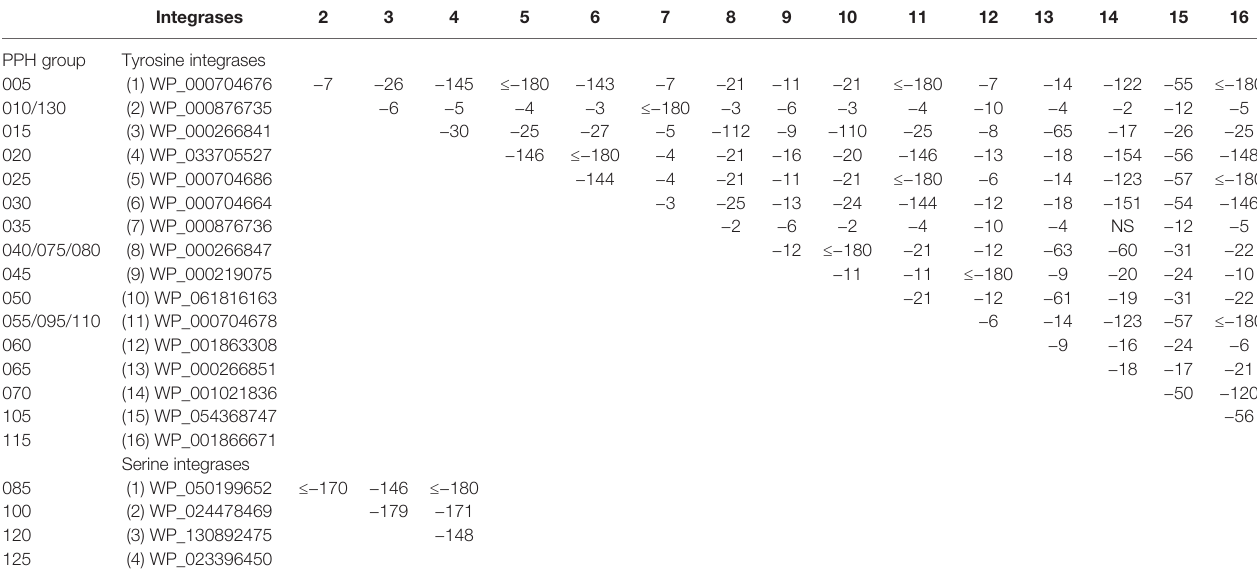
TABLE 3 | Sequence similarities among tyrosine and serine integrases of PPHs a .